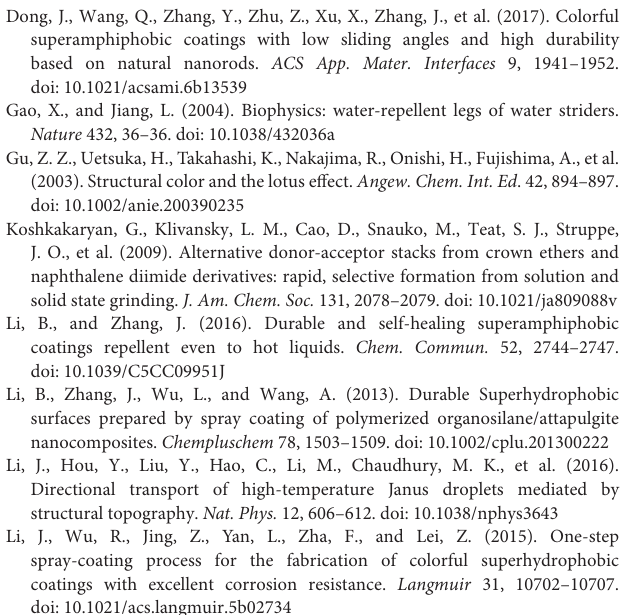
of the coatings, which can be regulated by the concentrations of PAL/IOR, PFDTES, and TEOS and the solid-state grinding time. The colorful superamphiphobic coatings feature high contact angles and low sliding angles for water and various organic liquids with surface tension as low as 23.8 mN m − 1